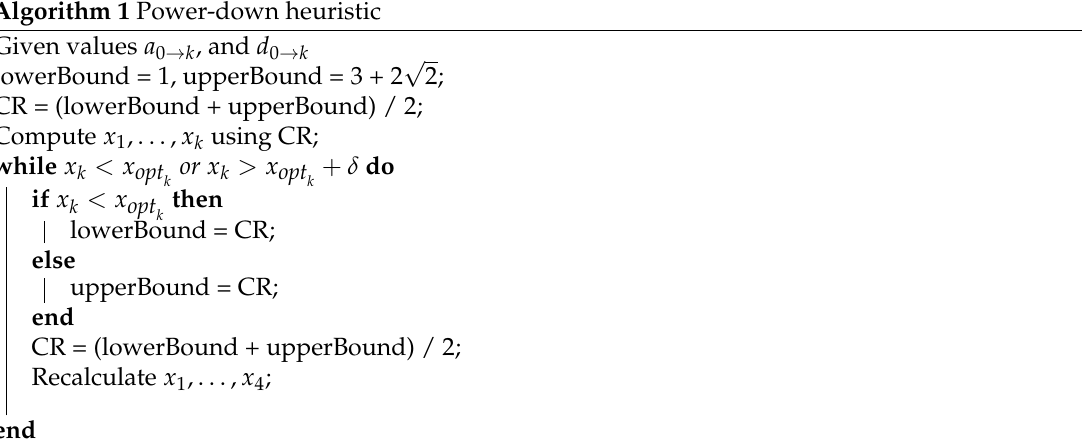
Algorithm 1 Power-down heuristic